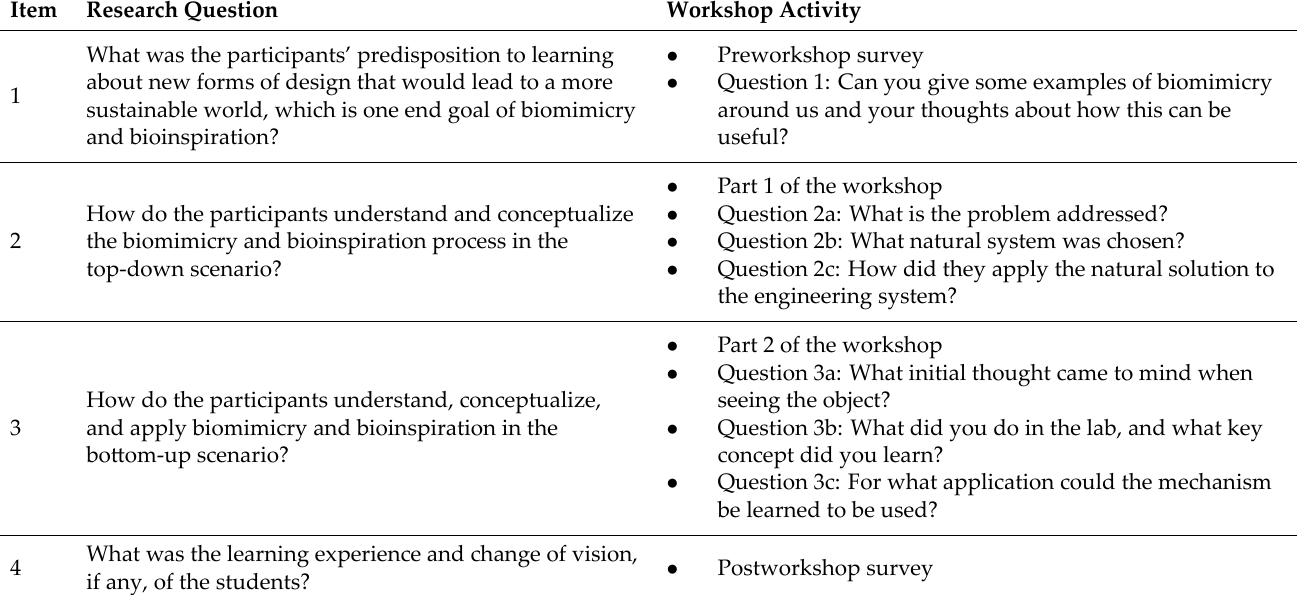
Table 3. Summary of research questions and activities carried out during the workshop to answer thesis research